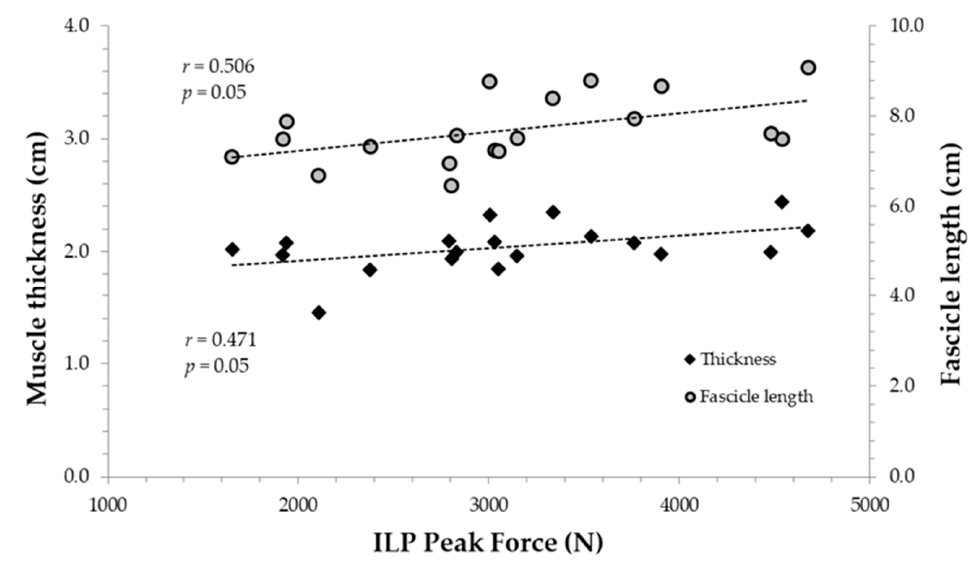
Figure 4. Correlations between ILP-PF and VL muscle thickness and fascicle length.